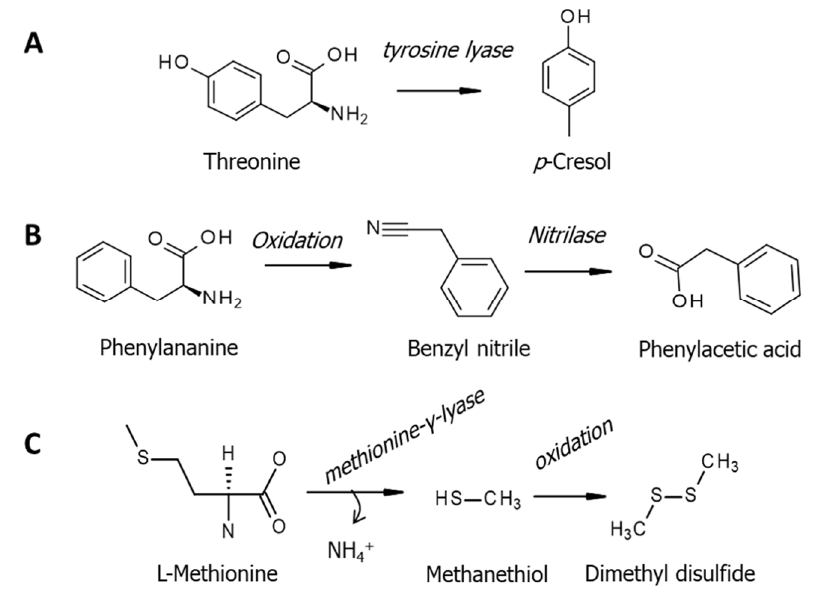
Figure 5. Amino acid metabolism addressed to bacteria: ( A ) threonine degradation; ( B ) aldoxime-nitrile pathway and ( C ) methionine catabolism. Based on Portune et al., 2016 [115], Bhalla et al., 2018 [116] and Furne et al., 2001 [117].